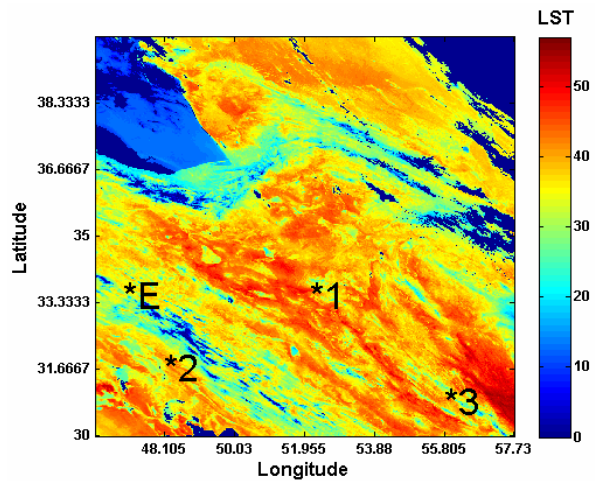
Fig. 9. Same as Fig. 7 but for Borujerd city on 25 March Figure 9. Same as Figure 7 but for the Borujerd city on 25 March 2006. 3